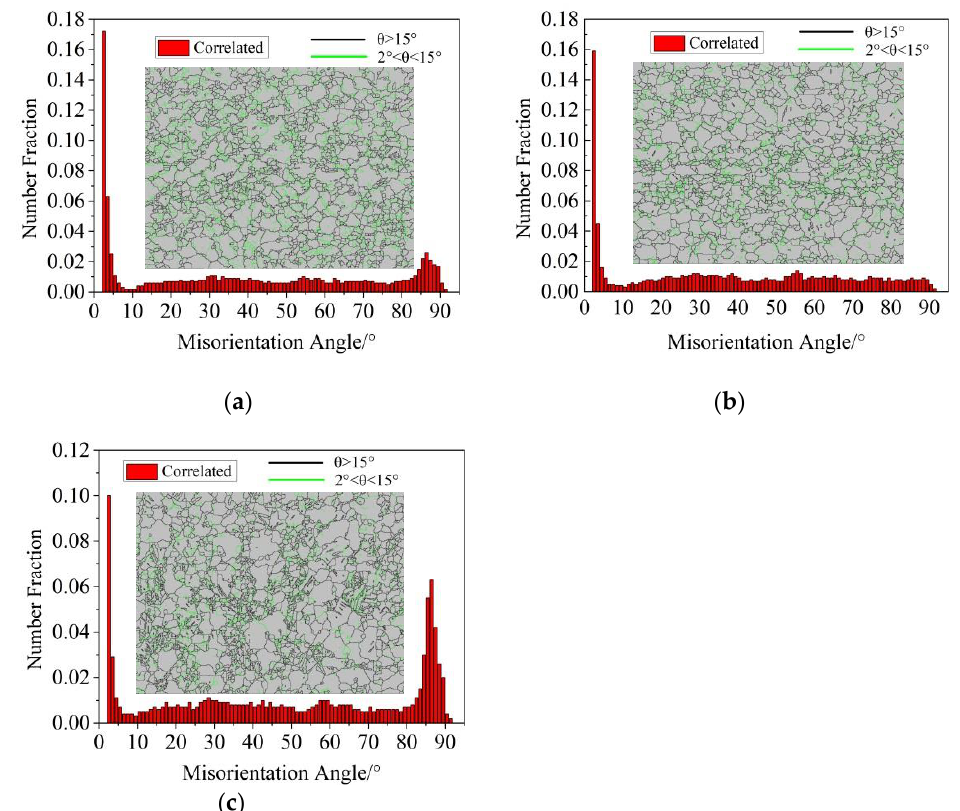
Figure 7. The grain boundary map and grain boundary misorientation map of different samples under axial tension of 0.08: ( a ) T0 sample, ( b ) T45 sample, ( c ) T90 sample.